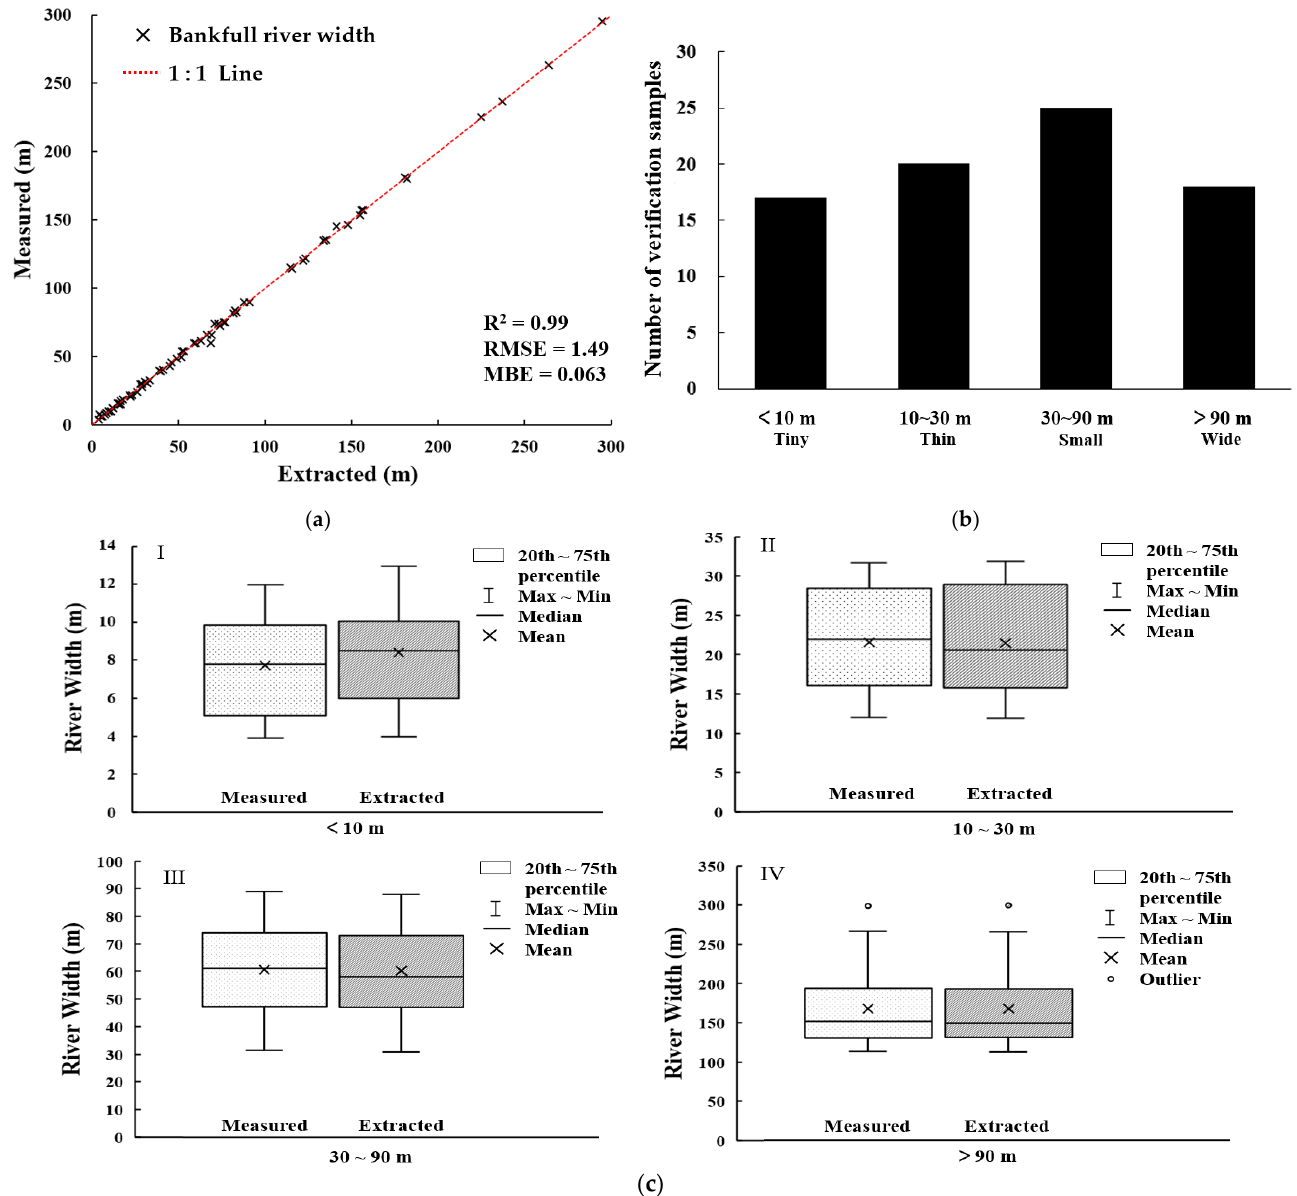
Figure 12. Accuracy evaluation of the river widths. ( a ) Comparison between the extracted river widths and measured data. ( b ) Distribution diagram of measured river widths. ( c ) The difference between measured and extracted widths of tiny, thin, small and wide rivers was shown separately in the form of box